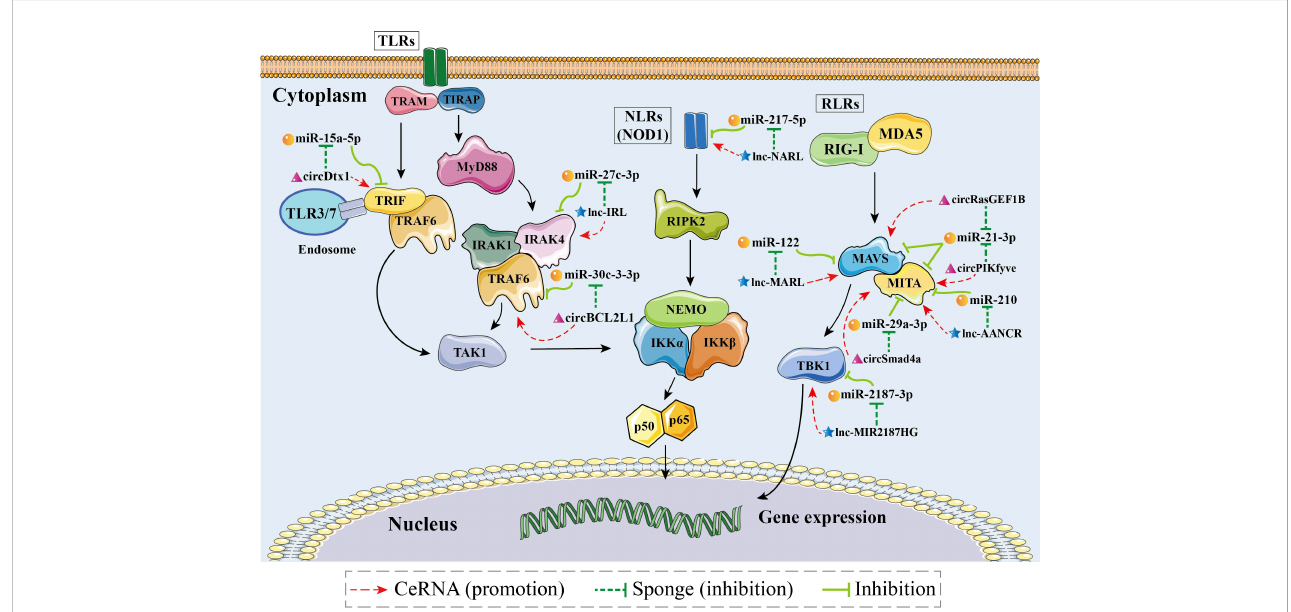
FIGURE 4 Schematic image of identi fi ed competing endogenous RNA (ceRNA) networks associated with nuclear factor-kappa B (NF- k B) pathways in aquatic